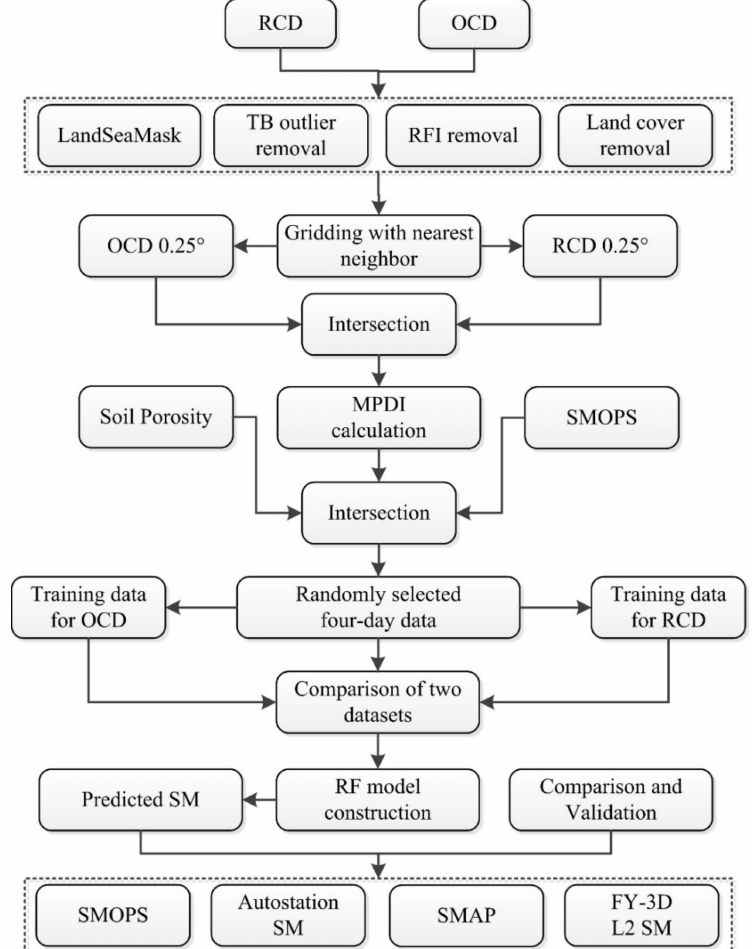
Figure 1. Flowchart for the RF model construction and